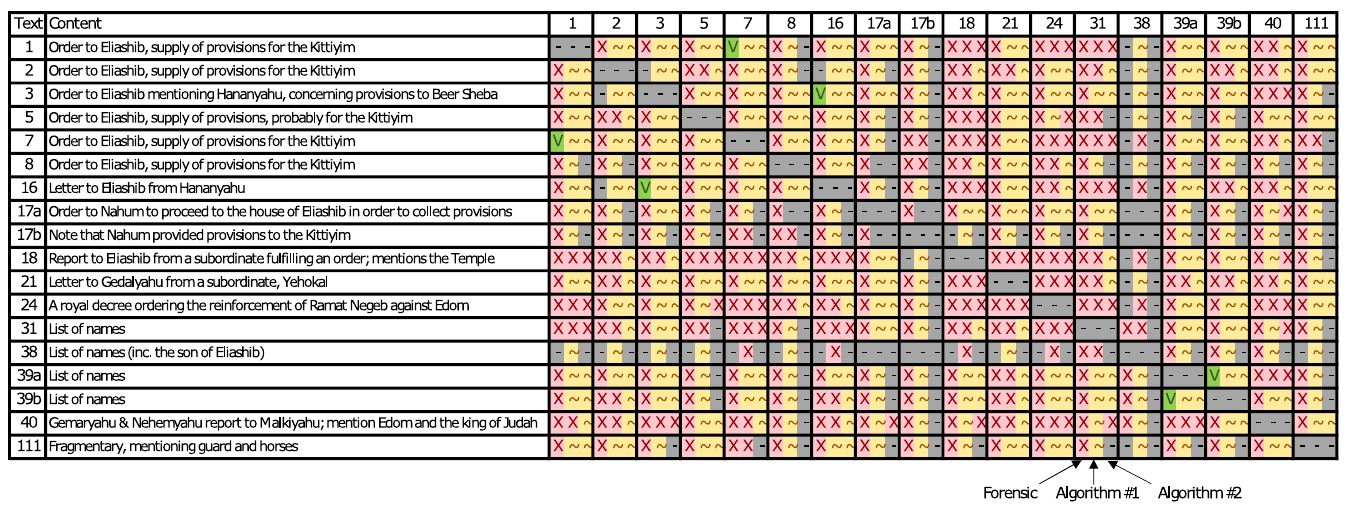
PLOS ONE | https://doi.org/10.1371/journal.pone.0237962 September 9,